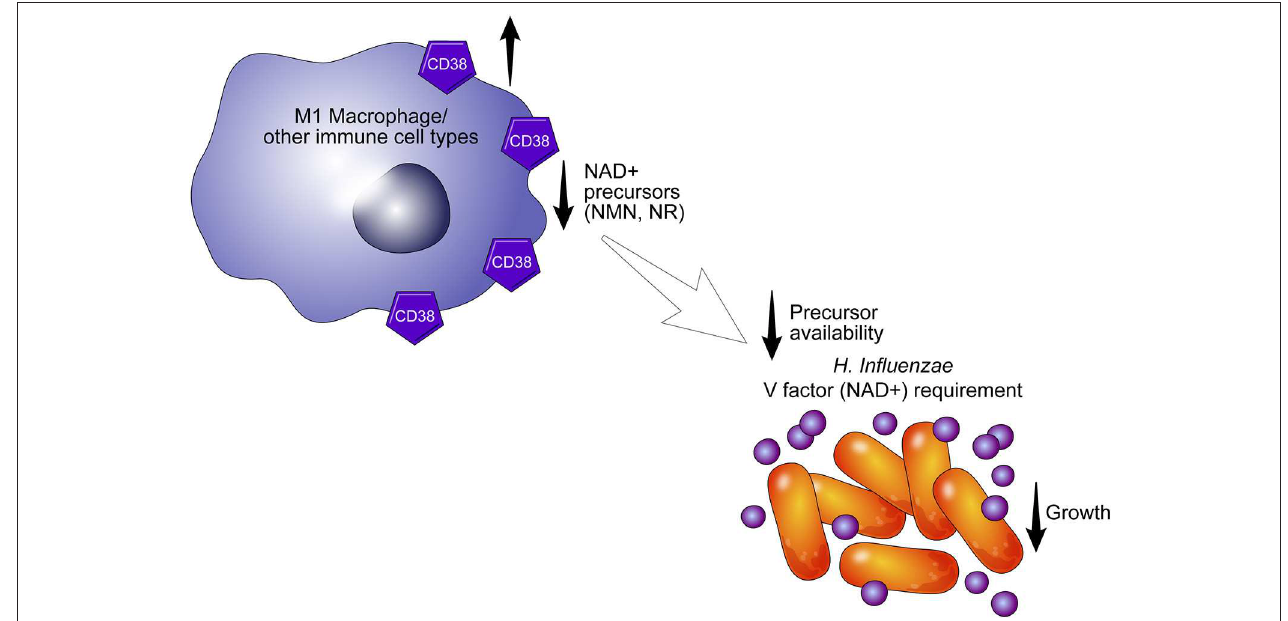
FIGURE 3 | CD38 may alter the availability of NAD + precursors. CD38 + cells may limit the growth of pathogens such as H. aegyptius, H. influenzae, H. haemolyticus, H. parainfluenzae, and H. parahaemolyticus by degrading extracellular NAD + precursors required for NAD + synthesis in bacteria. In the absence of NAD and its precursors (V factor), pathogens undergo metabolic collapse.